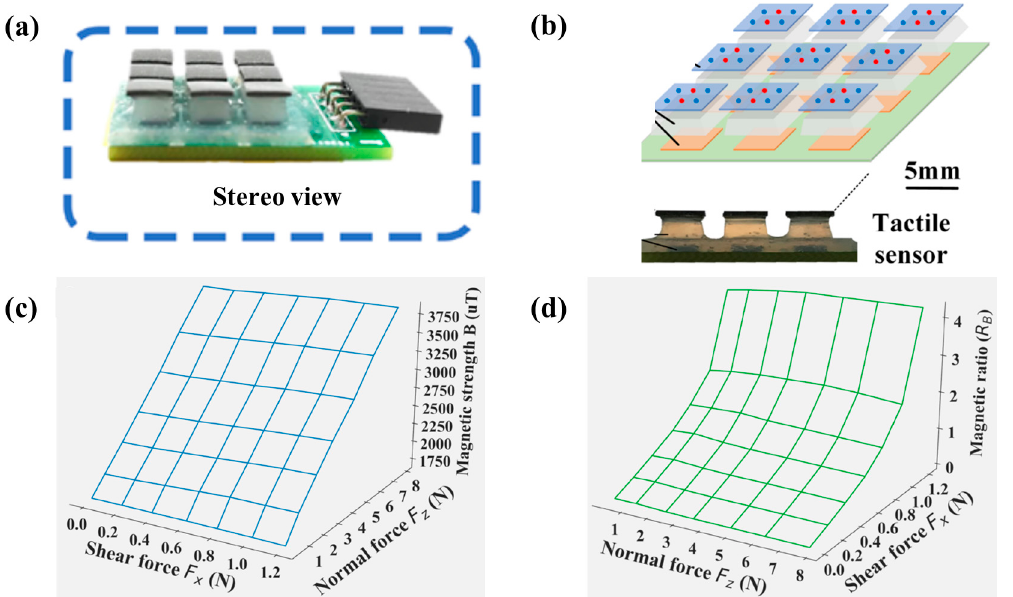
Figure 12. ( a ) Stereo view of the soft tactile sensor with a flat surface in a 3-by-3 array. Reprinted with permission from Ref. [51]. Copyright 2021, The American Association for the Advancement of Science; ( b ) Structure of the sensor with magnetic films which are magnetized into Halbach arrays. Reprinted with permission from Ref. [51]. Copyright 2021, The American Association for the Advancement of Science; ( c ) The magnetic strength B under both shear and normal forces. Reprinted with permission from Ref. [51]. Copyright 2021, The American Association for the Advancement of Science; ( d ) The magnetic ratio R B under both shear and normal forces. Reprinted with permission from Ref.